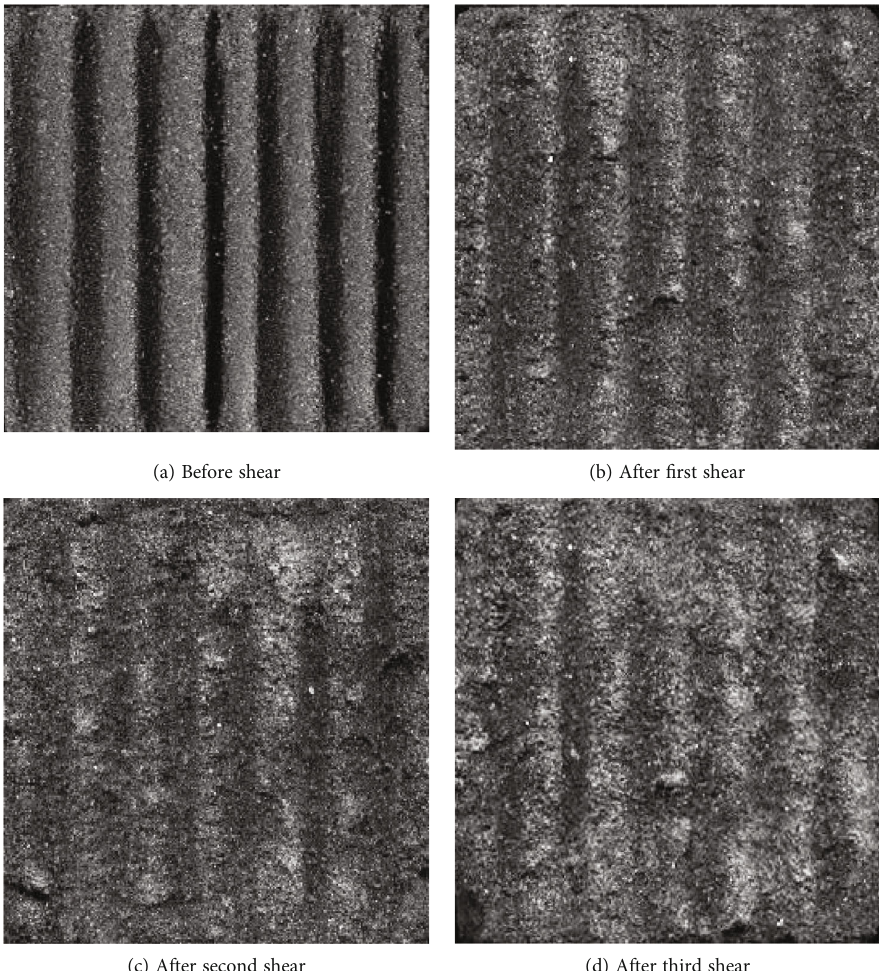
Figure 8: Wear conditions of structural planes with an undulating angle of 45 ° under a cyclic shear